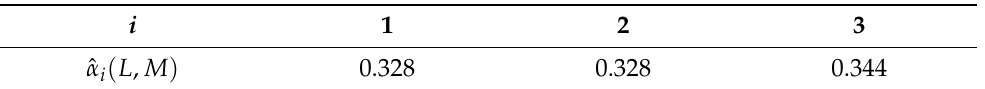
Table 6. The estimated values of the initial law a i in the case of L = 1000 trajectories with censoring at the beginning and/or at the end.